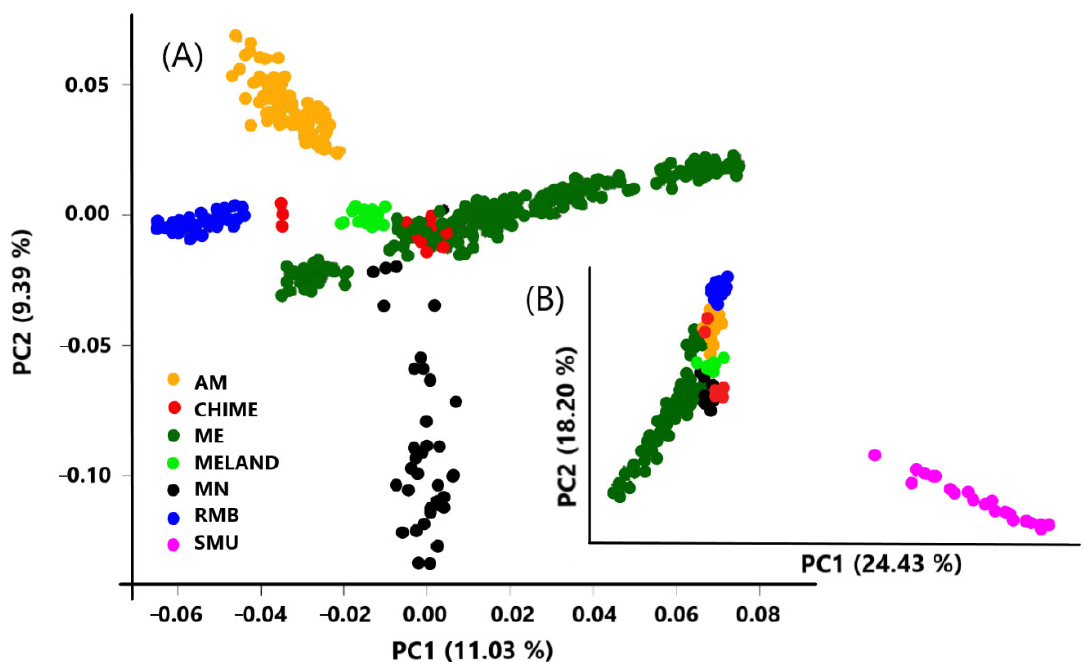
Figure 2. Genomic principal component analysis of the Merino-derived population with Mouflon ( B ) and without Mouflon ( A ) as outgroup. Breeds: AM (Australian Merino), CHIME (Chinese Merino), MELAND (Landschaft Merino), RMB (Merino of Rambouillet), MN (Spanish Black Merino), and ME (Spanish White Merino). Outgroup species: SMU (Mouflon).